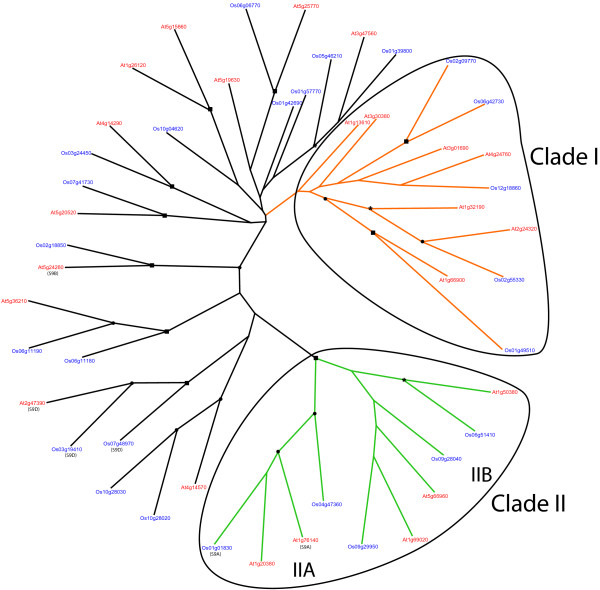
Unrooted N-J tree computed from multiple sequence alignments of Arabidopsis (red) and rice (blue) prolyl oligopeptidase domains. Prolyl oligopeptidase-like domains were aligned using ClustalW [95] program and the alignments were exported to Phylip package [96] for representing the Neighbor-Joining tree (see methods). The colors and circles represent the two evolutionary clades identified in the analysis (see text for details). Clade I is represented in Orange, Clade II is shaded green. For clarity, bootstrap values were replaced with symbols representing bootstrap percentages >50%. Bootstrap values between 50–60% are represented by an asterix, circles represent bootstrap values from 60%–80% while bootstrap values >80% are represented by rectangles. Gene names correspond to those in Additional files 1 and 2. For brevity, rice gene names have been shortened to OsXXg##### instead of LOC_OsXXg#####, XX referring to chromosome 1–12 and a 5 digit number assigned to each gene. Subfamily assignments where possible are indicated in parentheses below the gene name (see Figure SF3 and text for details).